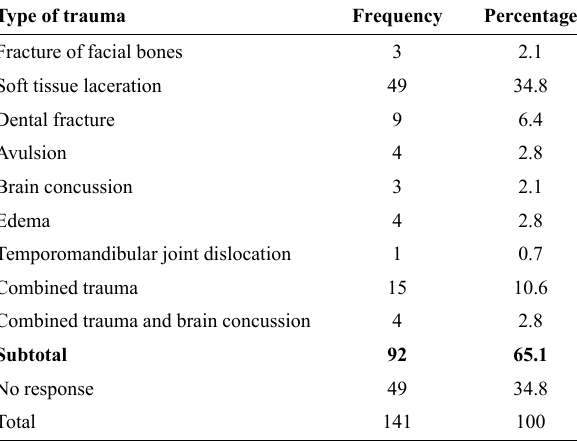
Table 4 - Distribution of responses per type of trauma suffered during the practice of contact sports.